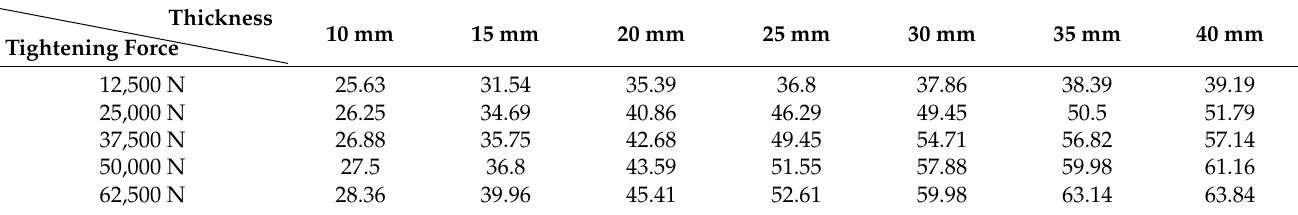
Table 2. The contact radius under different connection conditions (mm).